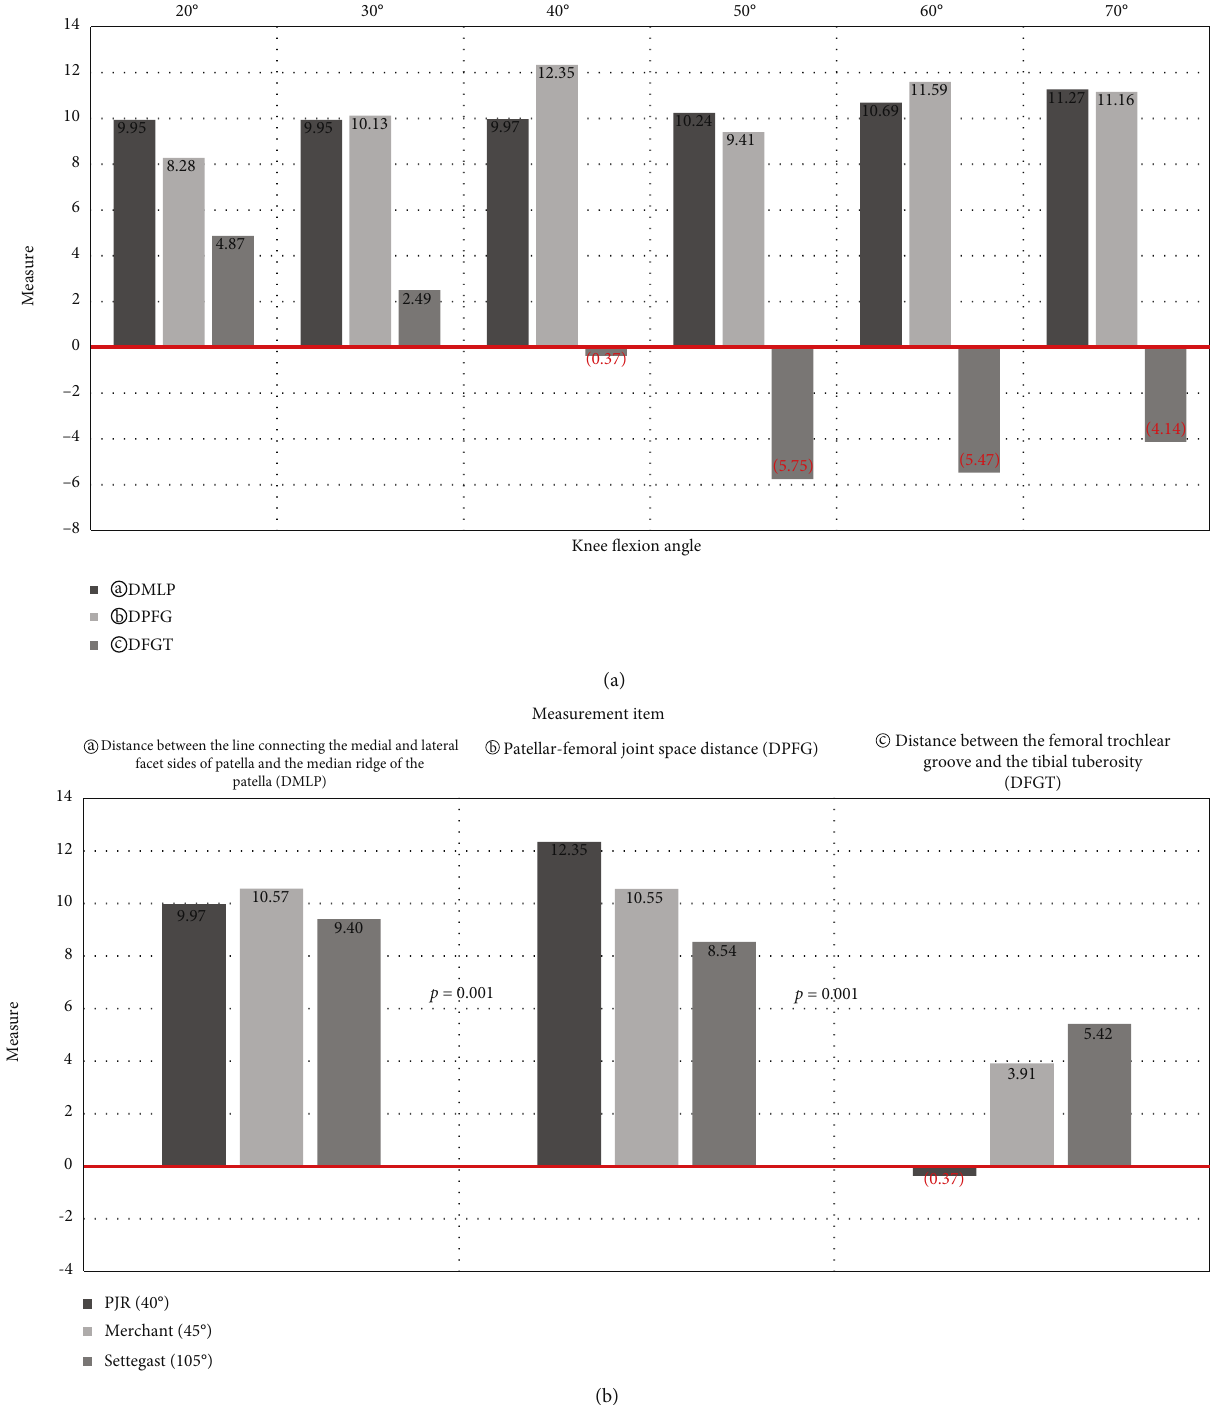
Figure 6: (a) Results of taking radiographic images at 20 ° to 70 ° using PJR and changing the knee fl exion angle at 10 ° . (b) A graph comparing the measurement results among PJR, Merchant method, and Settegast